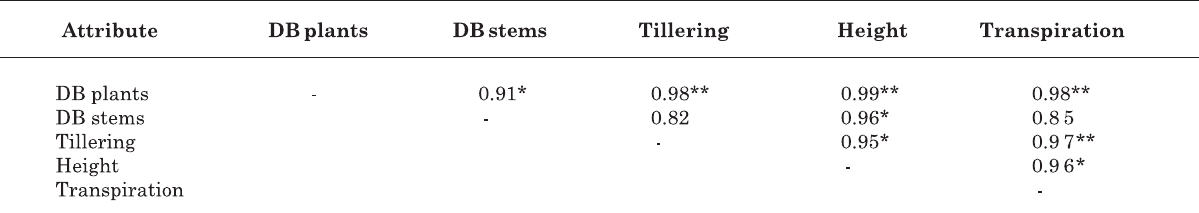
*,**: significant at 5 and 1 %,